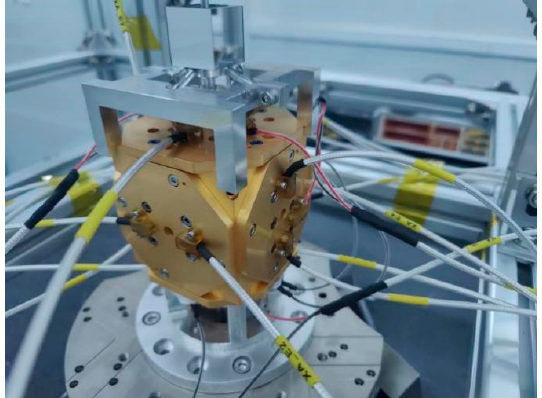
( b ) the experiment of bringing the planar transformer into the capacitive sensing circuit system.